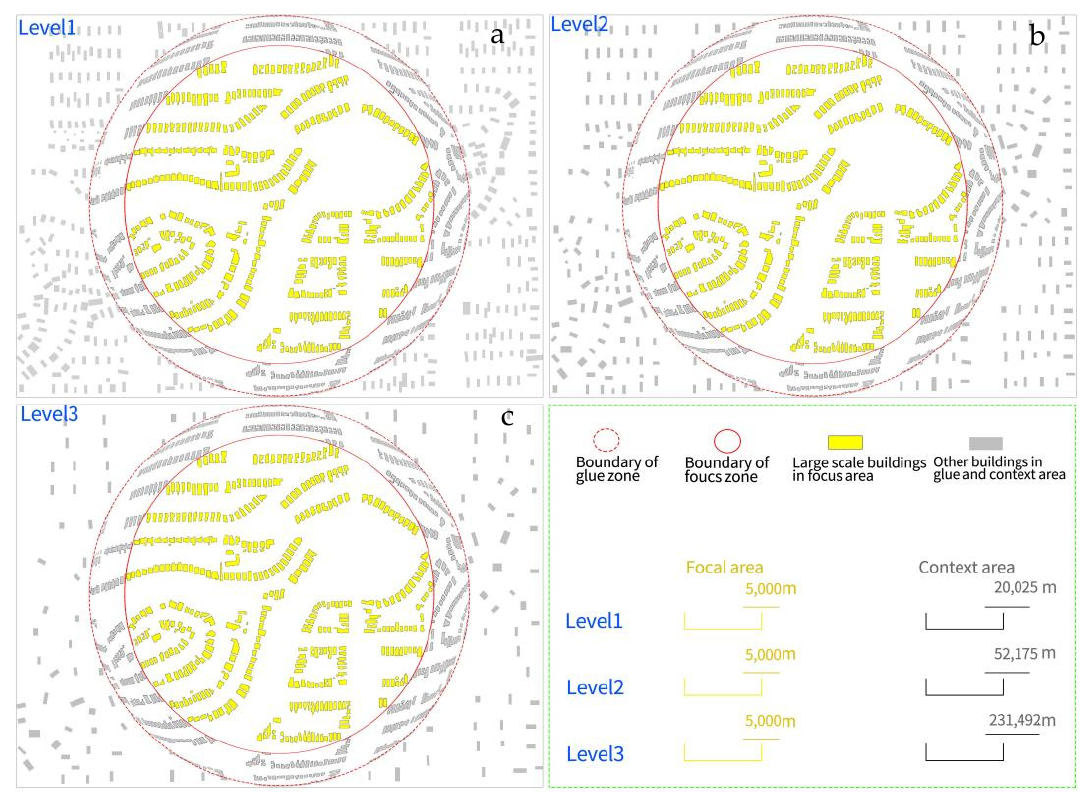
Figure 14. Multilevel variable-scale visualization results of buildings. ( a ) Variable-scale results for